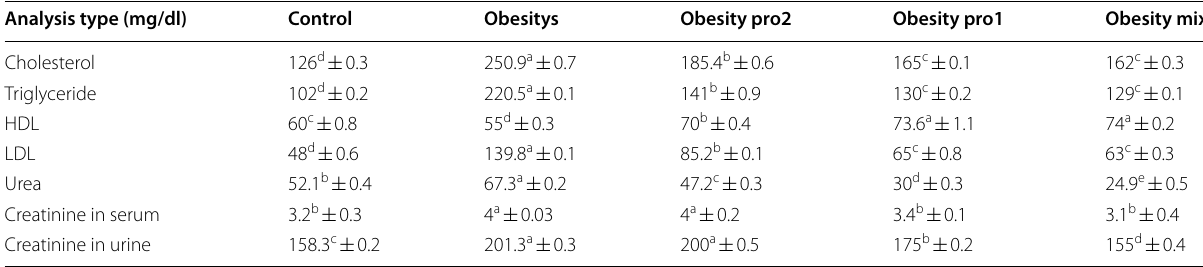
HDL High-density lipoprotein, LDL Low-density lipoprotein All data were expressed as the mean SE values within a column with different superscripts ± a,b,c Differ significantly at P <